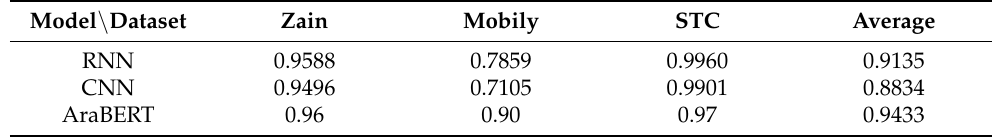
Table 10. Validation accuracy obtained by CNN, RNN, and AraBERT.